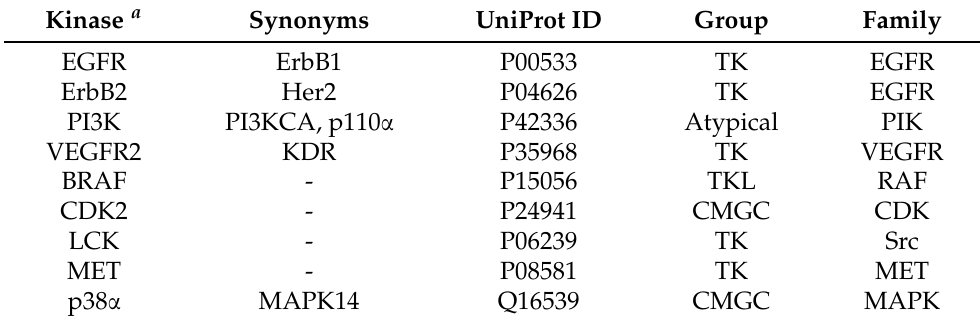
Table 1. List of kinases used in this study. Kinase a Synonyms Group